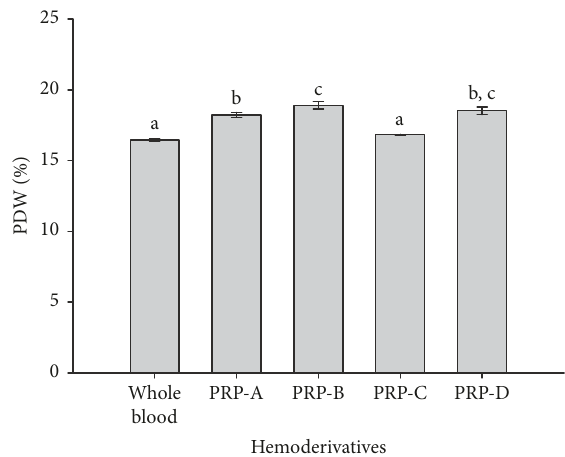
Figure 6: Mean ( ± SD) of TGF- 𝛽 1 concentration (pg/mL) in plasma and four bovine platelet-rich gel (PRG) supernatants (A, B, C, and D) and their respective PRP lysates (A, B, C, and D). a–d: